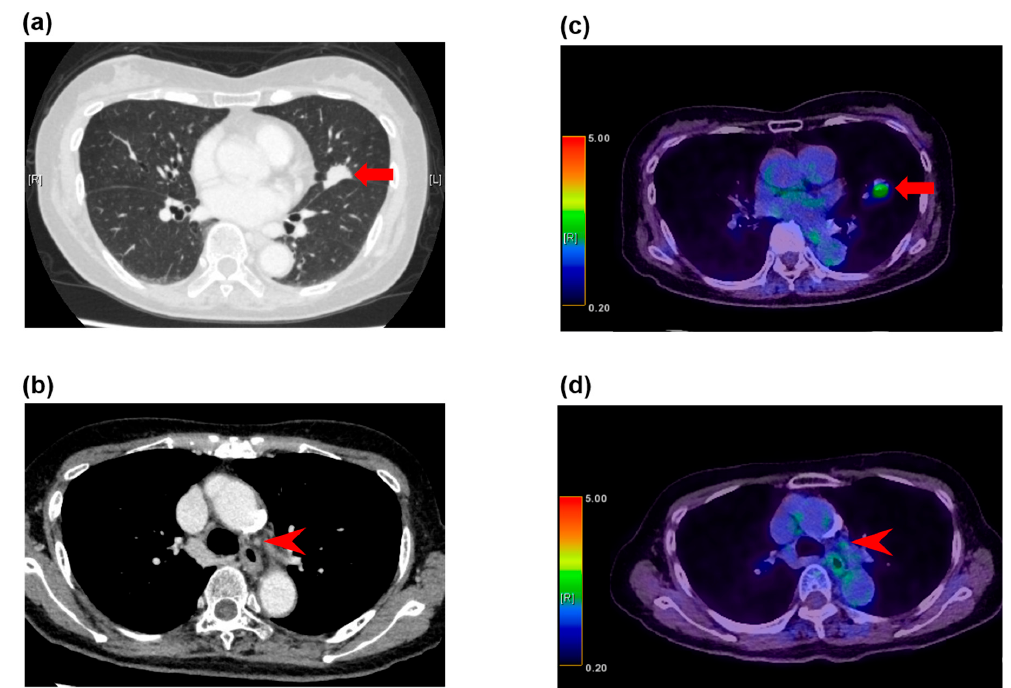
Figure 1. False negative fluorodeoxyglucose F 18 positron emission tomography (FDG-PET) findings in normal-sized lymph nodes in a 79-year-old woman with adenocarcinoma. ( a ) The computed tomography (CT) image shows a left upper lobe tumor (arrow), ( b ) and nonenlarged station 5 lymph nodes (arrowhead). ( c ) The FDG-PET/CT image shows FDG accumulation with a maximum